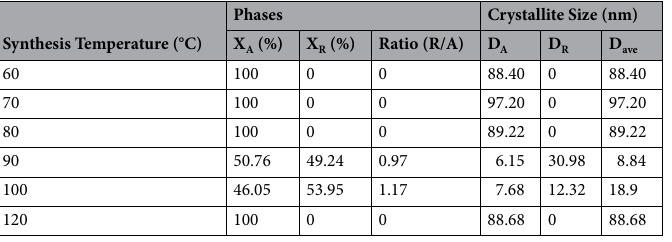
Table 1. Phase and crystallite size of TiO 2 .